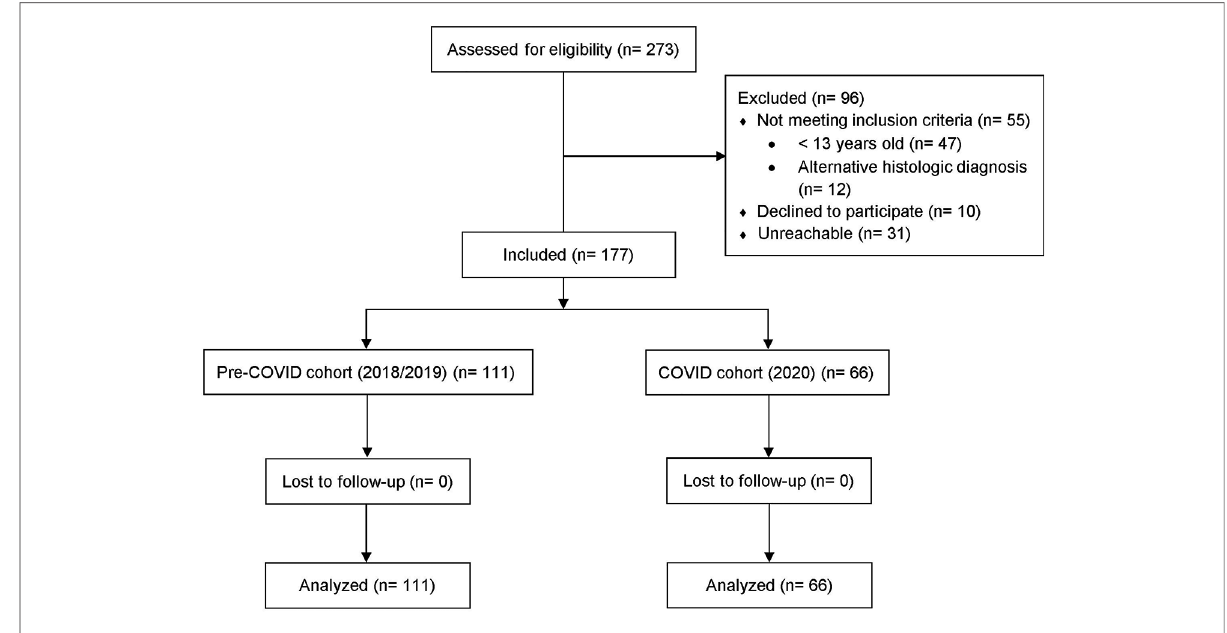
FIGURE 1 Patient fl ow